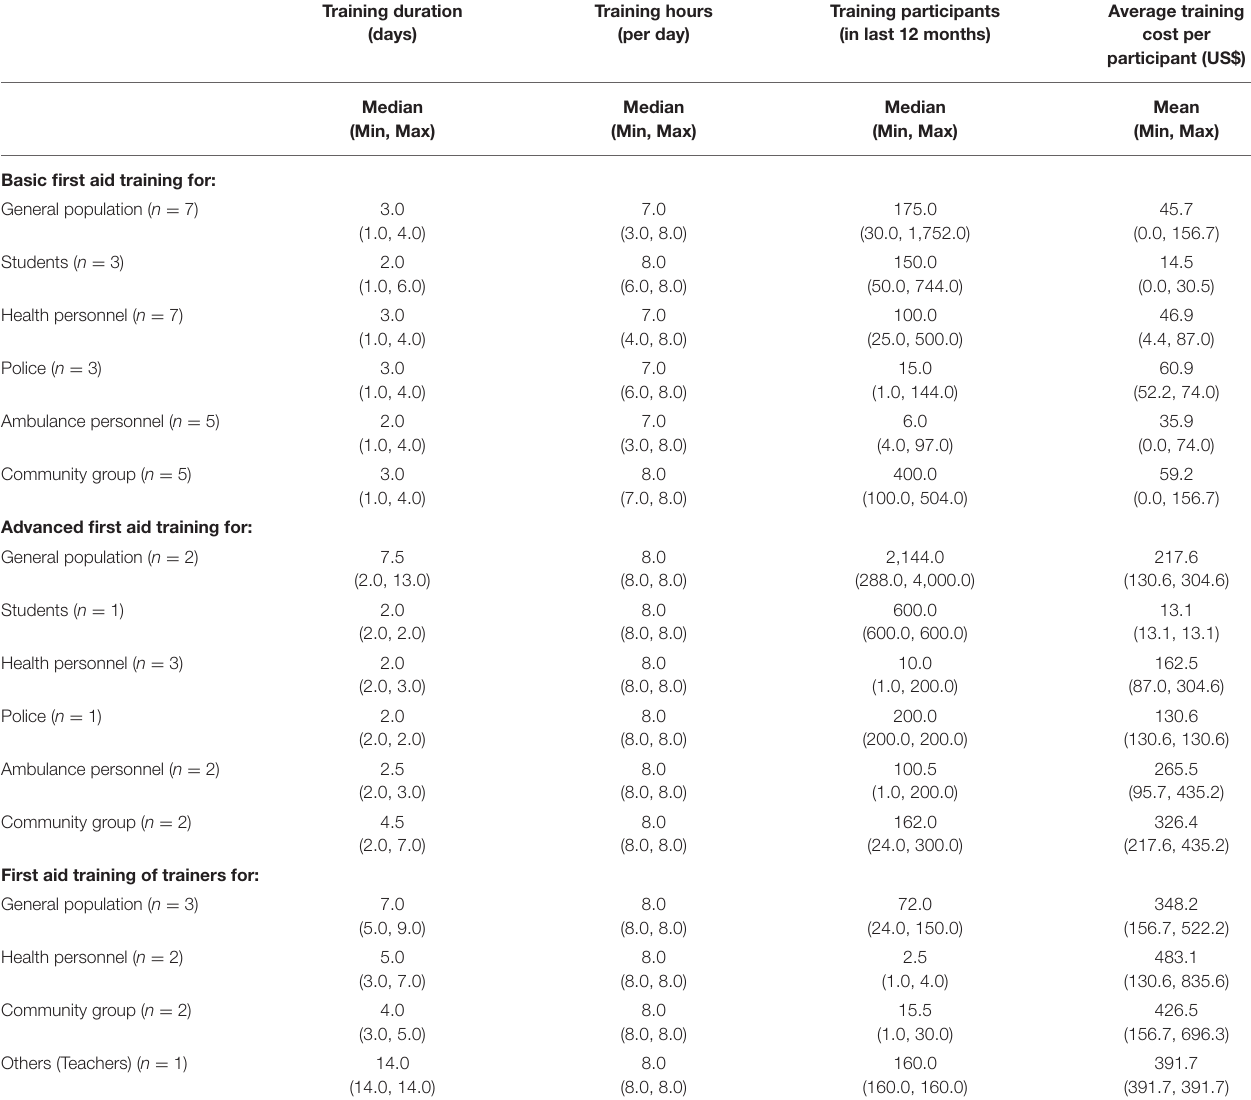
TABLE 3 | First response training types, duration, participants, and